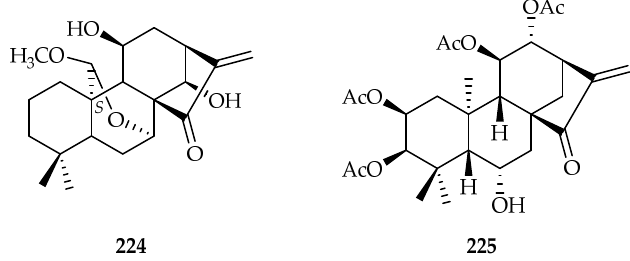
Figure 88. Structures of JDA-202 224 [138] and IsoA 225 [139].